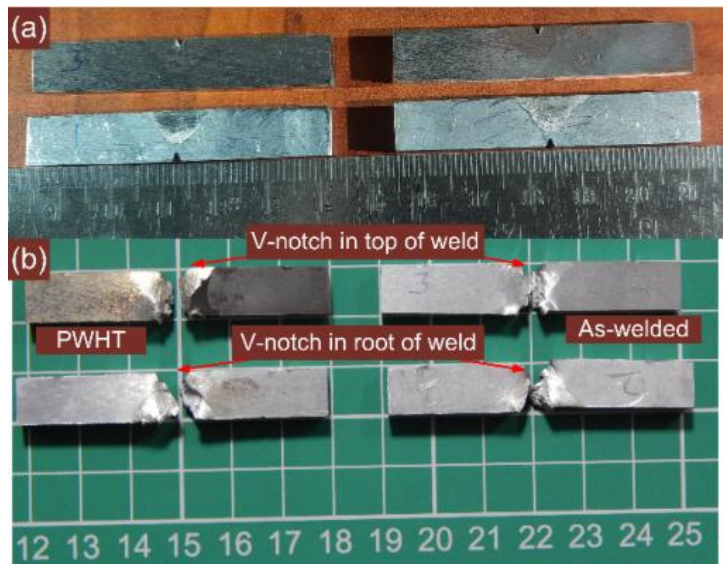
Figure 16. ( a ) Position of notch in top and bottom portion, ( b ) fractured impact toughness specimen for the weld metal.